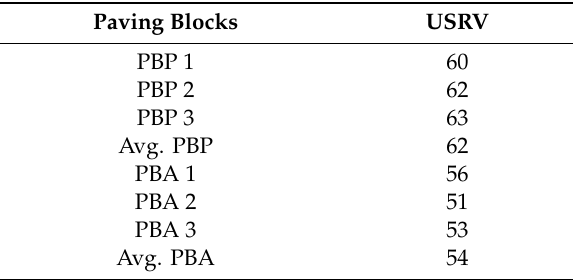
Table 7. URSV tests